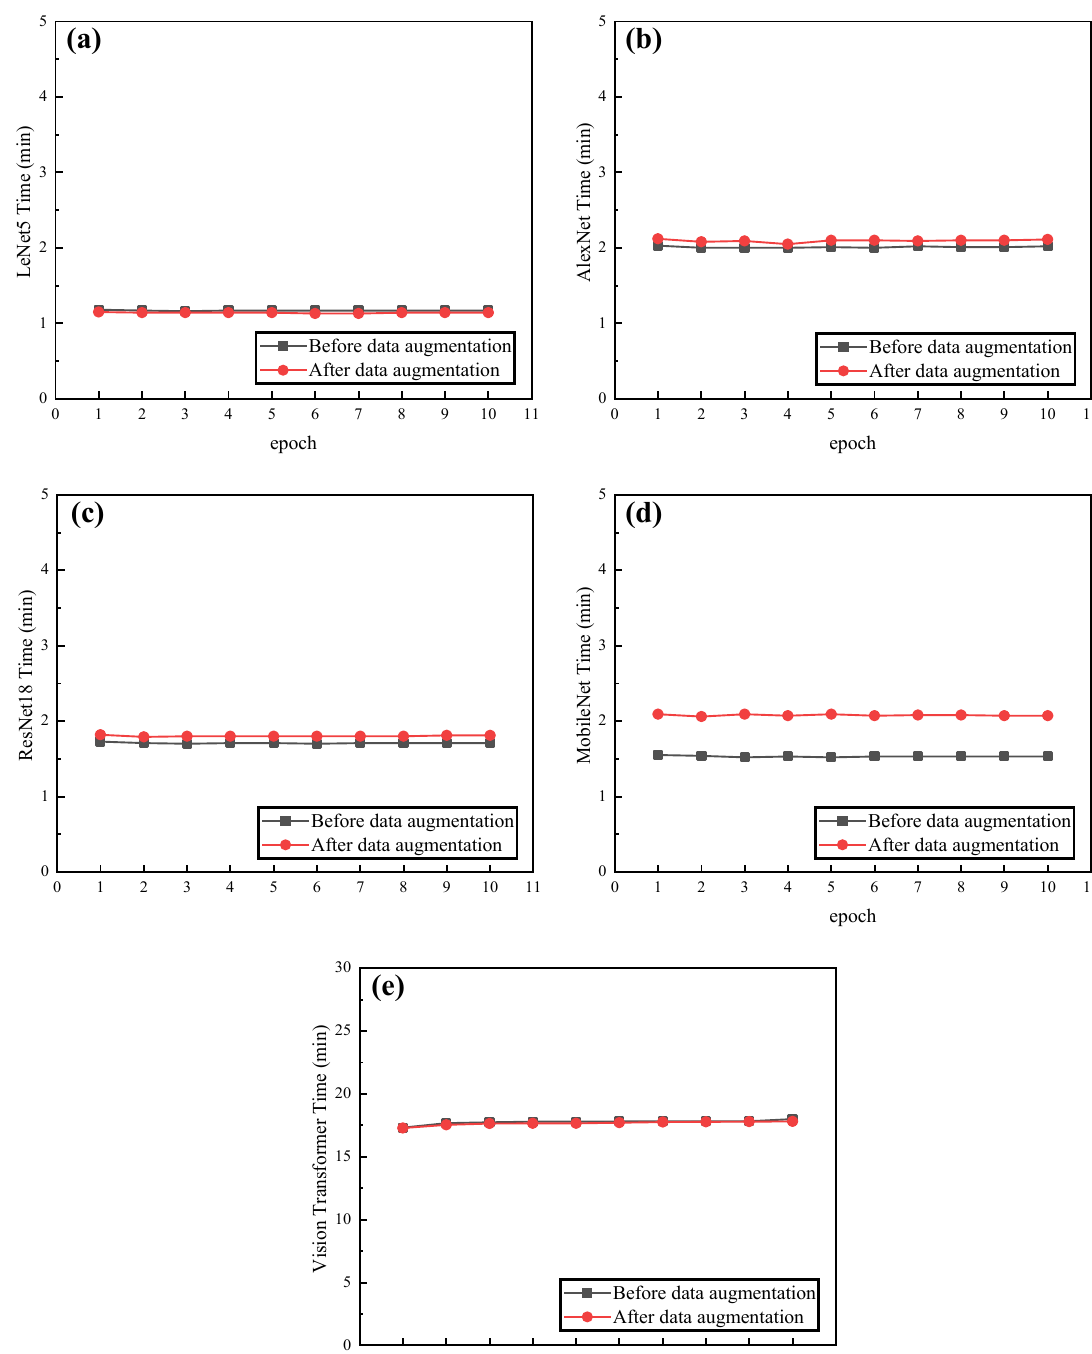
Figure 15. Comparison of the computational efficiency of each model after GPU loading before and after data augmentation. ( a ) Comparison of the computational efficiency of LeNet5 model. ( b ) Comparison of the computational efficiency of AlexNet model. ( c ) Comparison of the computa- tional efficiency of ResNet18 model. ( d ) Comparison of the computational efficiency of MobileNet model. ( e ) Comparison of the computational efficiency of Vision Transformer